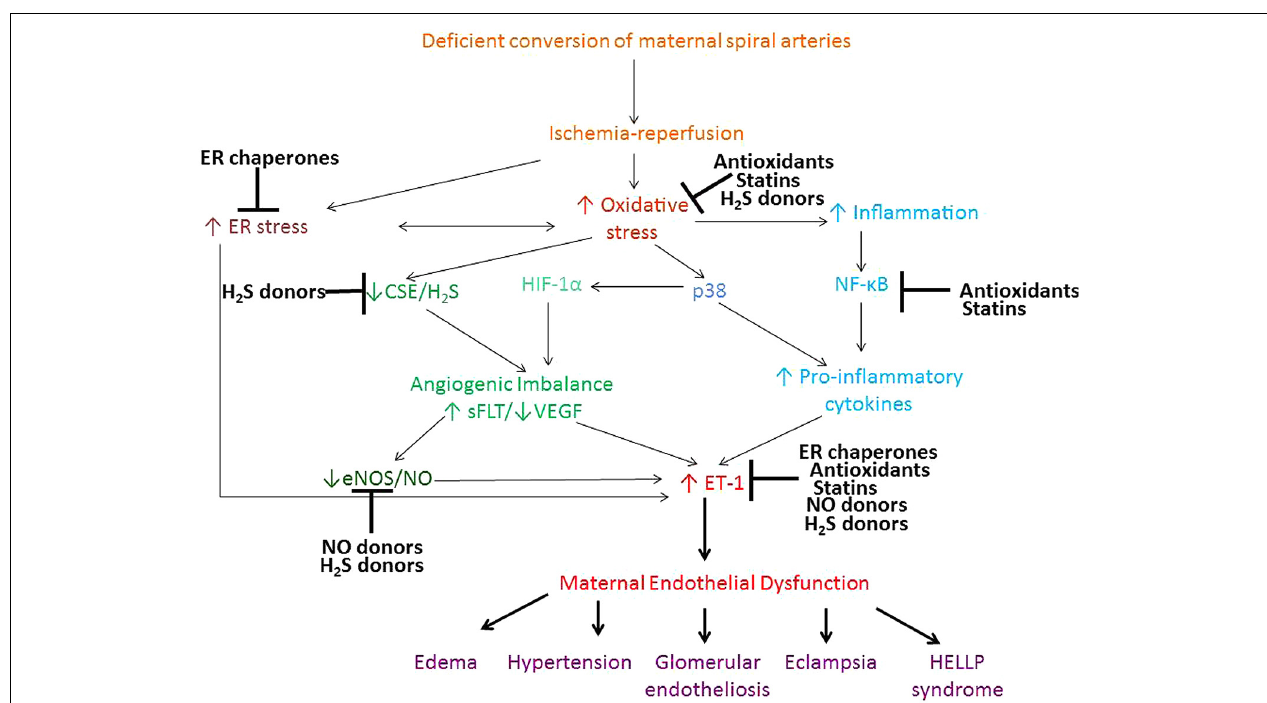
proapoptotic p38 and inflammatory NF- κ B pathway.These pathways promote increased shedding of microparticles, anti-angionenic factors and inflammatory cytokines, which lead to development of the peripheral maternal symptoms. Antioxidants, ER chaperones, NO and H 2 S donors and statins all display pleitrophic effects, targeting inflammatory, stress, antioxidant pathways, as well asVEGF and NO